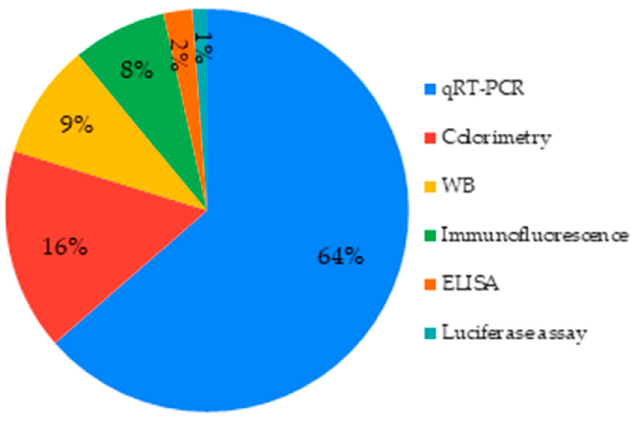
Figure 11. Techniques used to assess cell